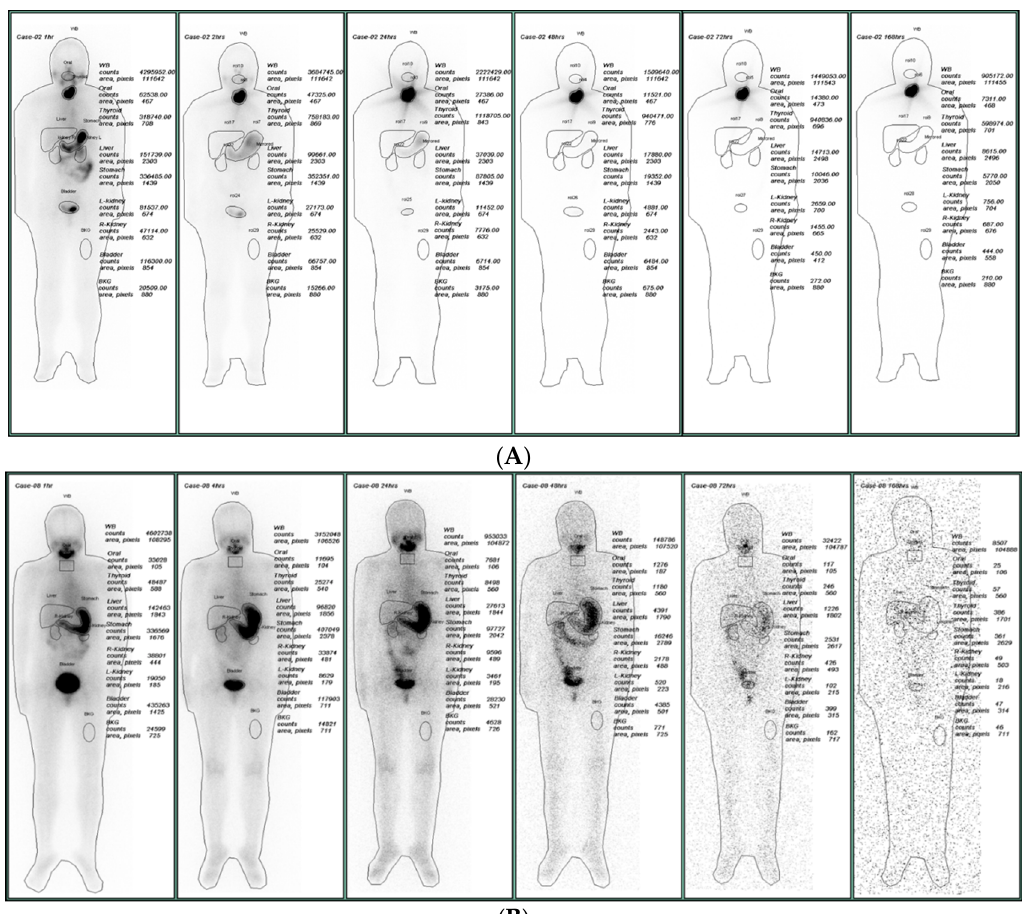
Figure 2. The original plot from the gamma camera of patients ( A ) no. 2 and ( B ) no. 8 for comparing. The six plots were consecutively downloaded from the facility after the gamma scanning after 1, 4, 24, 48, 72, and 168 elapsed hours. The marked ROIs were assigned as St (stomach), WB (body fluid + whole body), Th (thyroid), Bl (bladder), and BKG (background) to derive the count × pixel − 1 × s − 1 for further analysis.